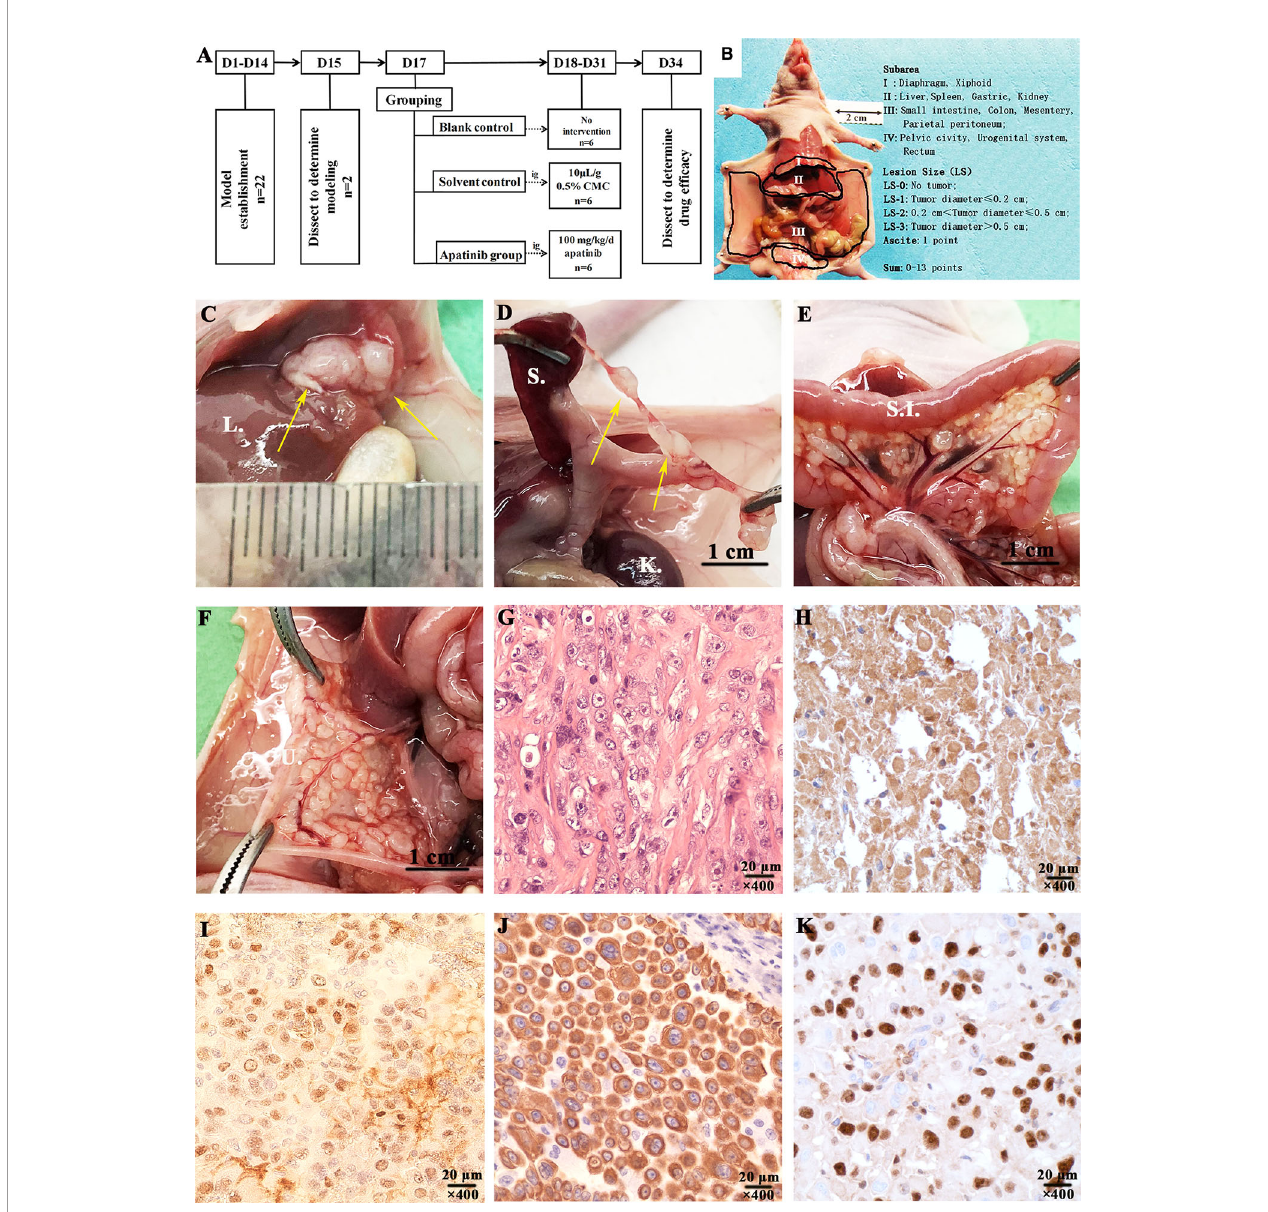
FIGURE 4 | Experimental procedures and characterization of the established malignant peritoneal mesothelioma (MPM) patient-derived xenograft (PDX) models. (A) Experimental procedures of establishment MPM PDX models and apatinib intervention study. (B) The subarea and scoring of ePCI score system (16). (C) Tumors invaded the liver of MPM PDX models (D) . The mesentery of spleen was invaded by tumors. (E) Tumors invaded mesentery of nude mice. (F) The mesentery of uterus was invaded by tumors. (G – K) Characterization of MPM PDX models was performed by HE and immunohistochemical staining, the expressions of Calretinin, WT-1, Cytokeratin 5/6, and Ki-67 were all positive, magni fi cation, ×400. L., liver; S., spleen; K., kidney; S.I., small intestine; U.